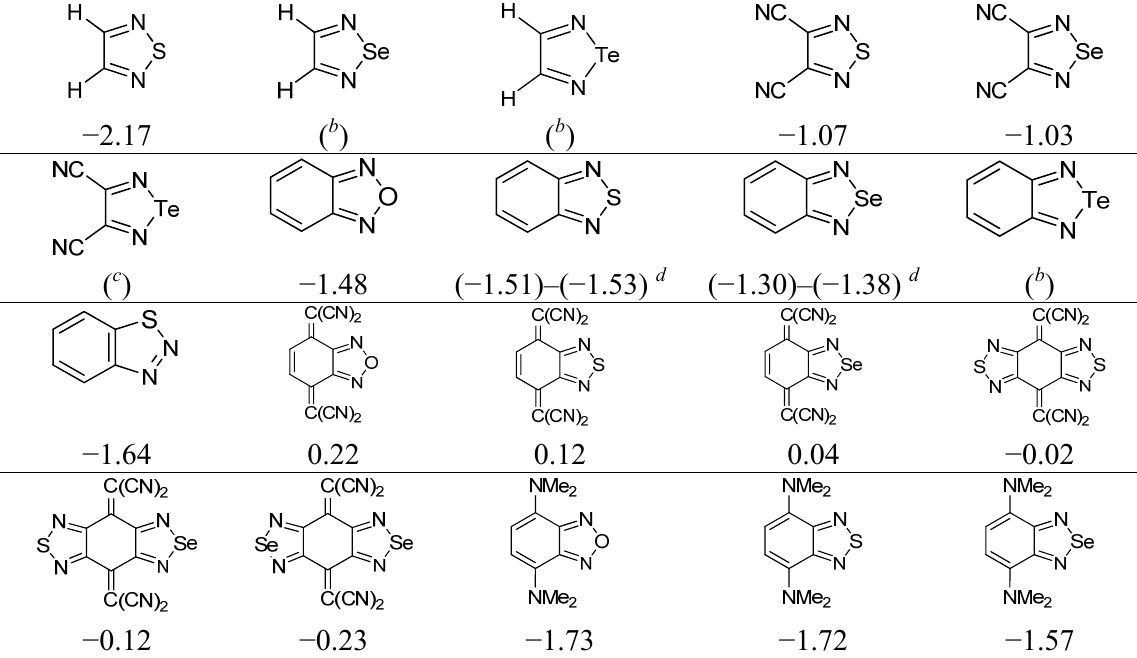
vs SCE) of selected chalcogen-nitrogen p